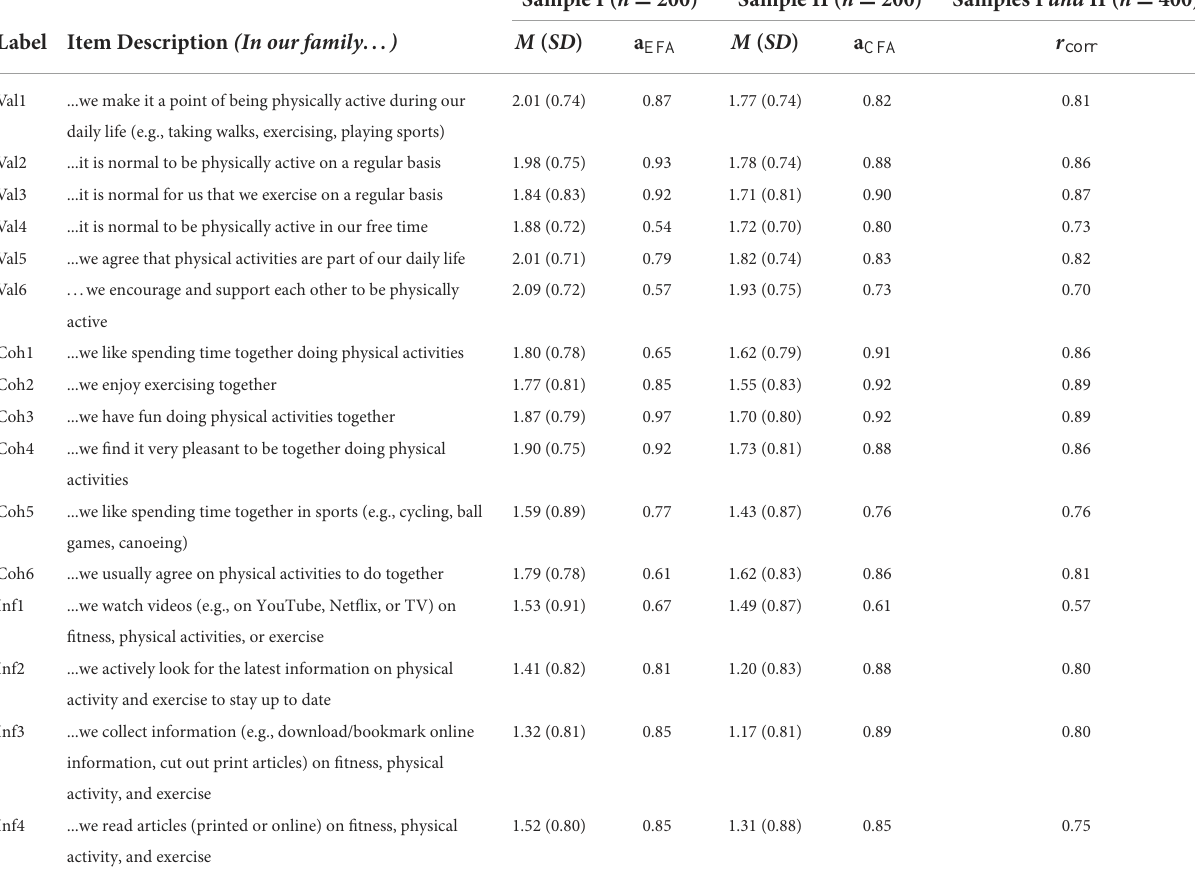
TABLE 1 Item descriptives, factors, and item parameters of FHC-PA (Sg). Sample I ( n = 200) Sample II ( n = 200) Samples I and II ( n = 400) Label Item Description (In our family...) M ( SD